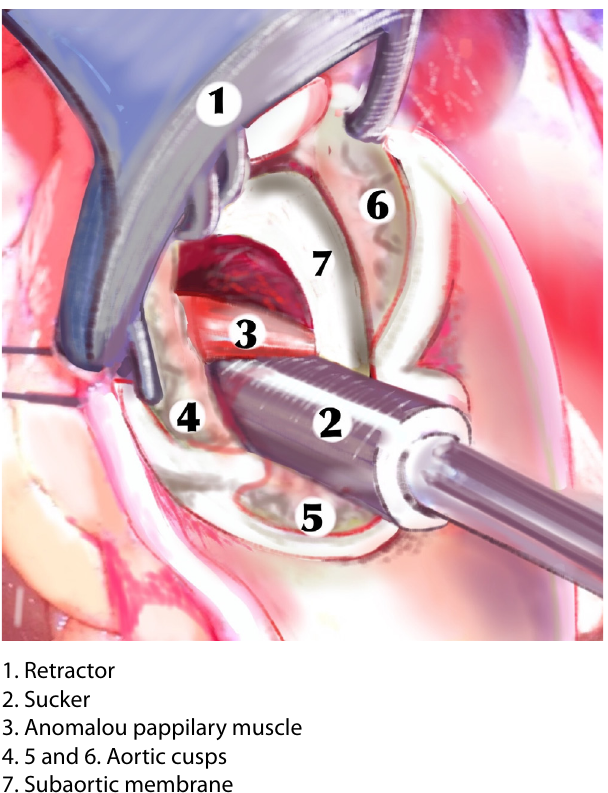
Fig. 3 - Schematic drawing. Vision of the surgeon.